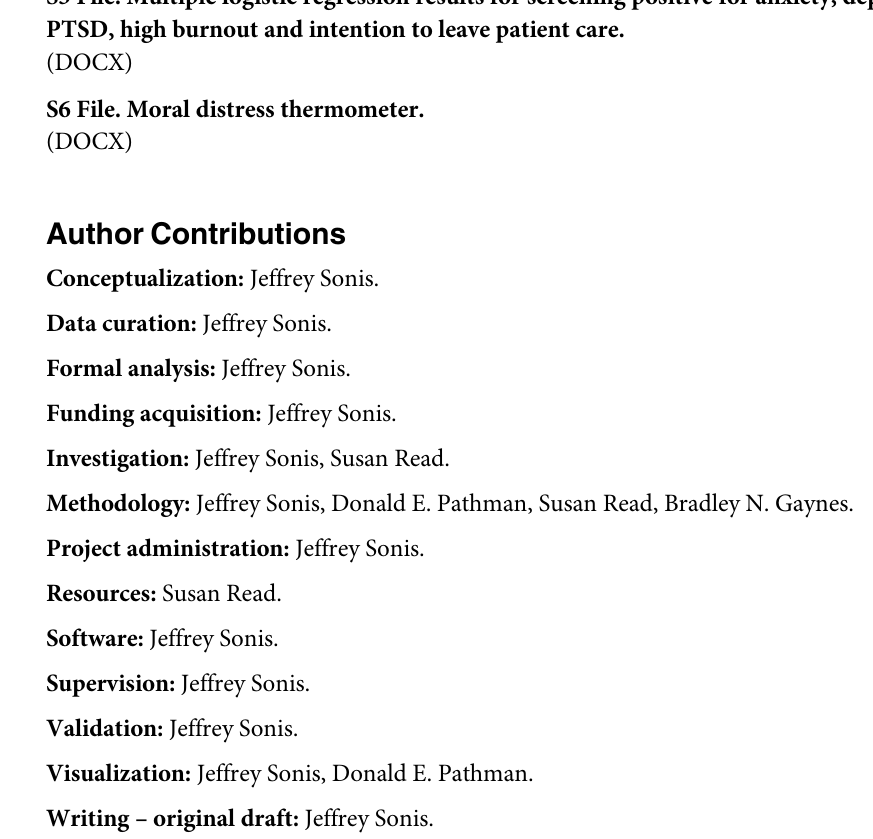
S4 File. Multiple linear regression for associations between individual and organizational predictors of moral distress, adjusted for potential confounding factors. S5 File. Multiple logistic regression results for screening positive for anxiety, depression, PTSD, high burnout and intention to leave patient